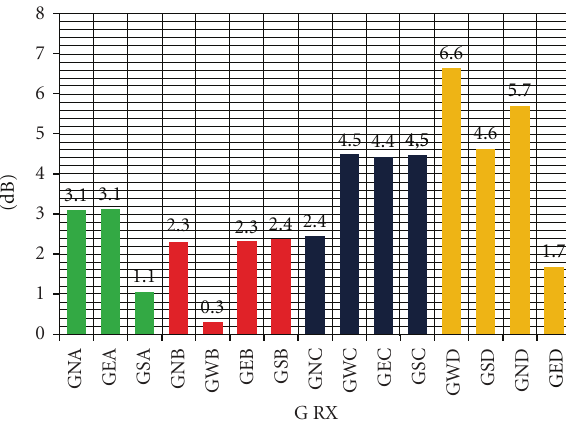
Figure 10: Insertion-loss comparison for the 4 × 4 square root topology of Figure 8, by considering injection from G4 and taking into account the inter-express lanes loss-contributions. Every intersection is optimized with standard elliptical